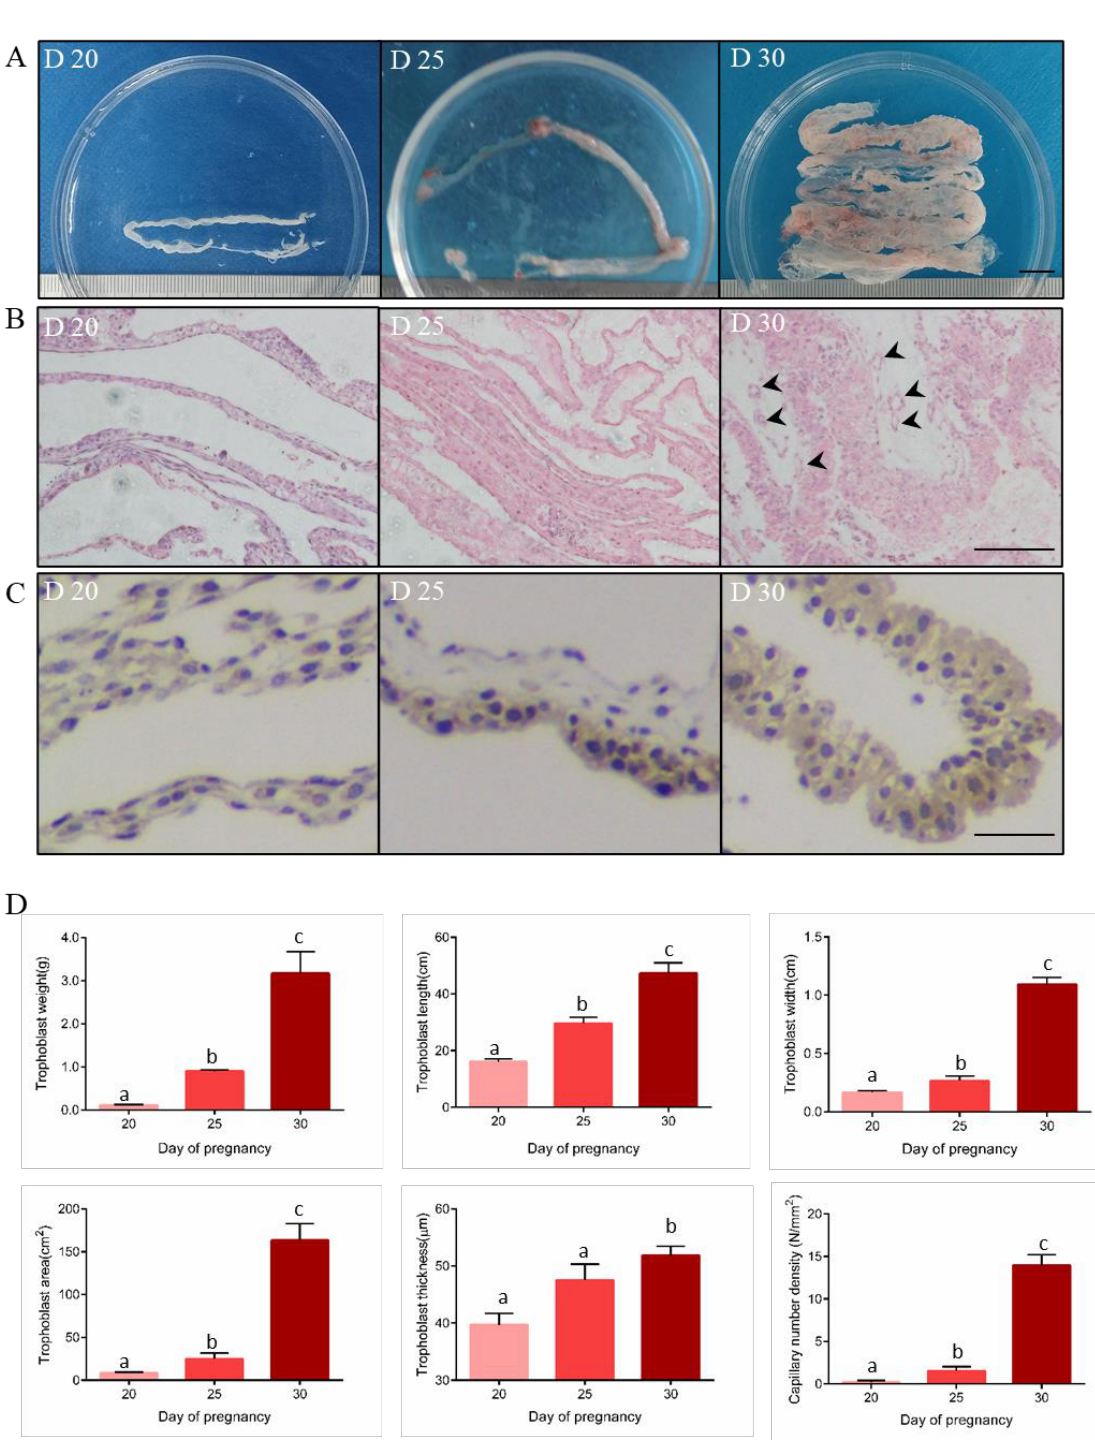
Figure 1. The morphological phenotype and histological structure of trophoblasts on the 20th, 25th, and 30th days of pregnancy (D20, D25, and D30) in Dazu black goats. ( A ). Representative images of trophoblast at the three-time points of early gestation. Scale bar: 1 cm. ( B ). Hematoxylin and eosin (HE) staining of trophoblast at three-time points of early gestation. Scale bar: 200 µ m. The black arrow indicates capillary position. ( C ). Immunohistochemical staining of SPP1 on trophoblast at the three-time points of early gestation. Scale bar: 50 µ m. ( D ). The average value of trophoblast weight ( µ m), length ( µ m), width ( µ m), area ( µ m 2 ), cross-section thickness ( µ m) and capillary number density (N/mm 2 ). n = 3 in each group. Data are expressed as mean ± SEM. Different lowercase letters in the same panel indicate statistical significance ( p < 0.05).